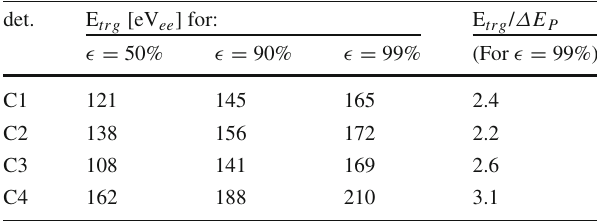
Table 10 Energy values E trg of Conus detectors, at which the trigger efficiency (cid:10) reaches characteristic values. The ratios of E trg ( (cid:10) = 99%) over Δ E P are reported as well